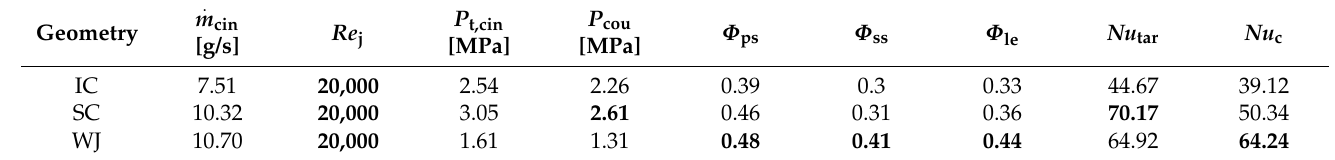
Table 4. Flow and heat transfer and parameters of the cases with the same jetting Reynolds number.